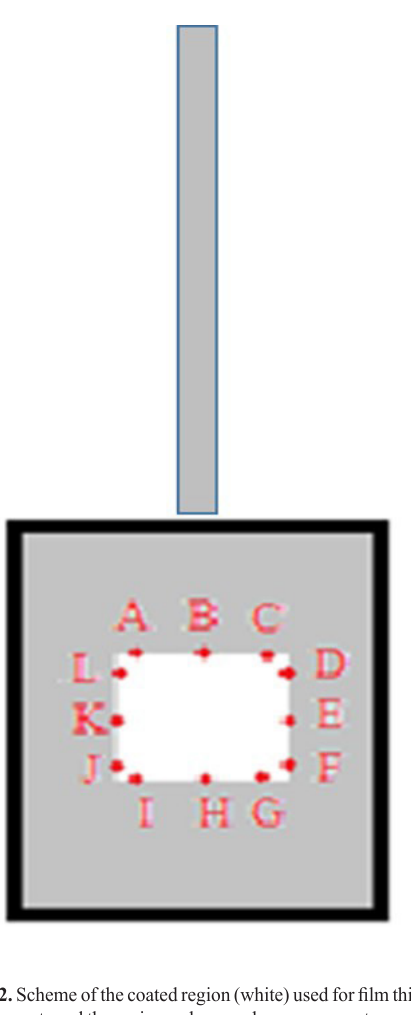
Figure 2. Scheme of the coated region (white) used for film thickness measurements and the regions where such measurements were taken marked by the letters A to L .